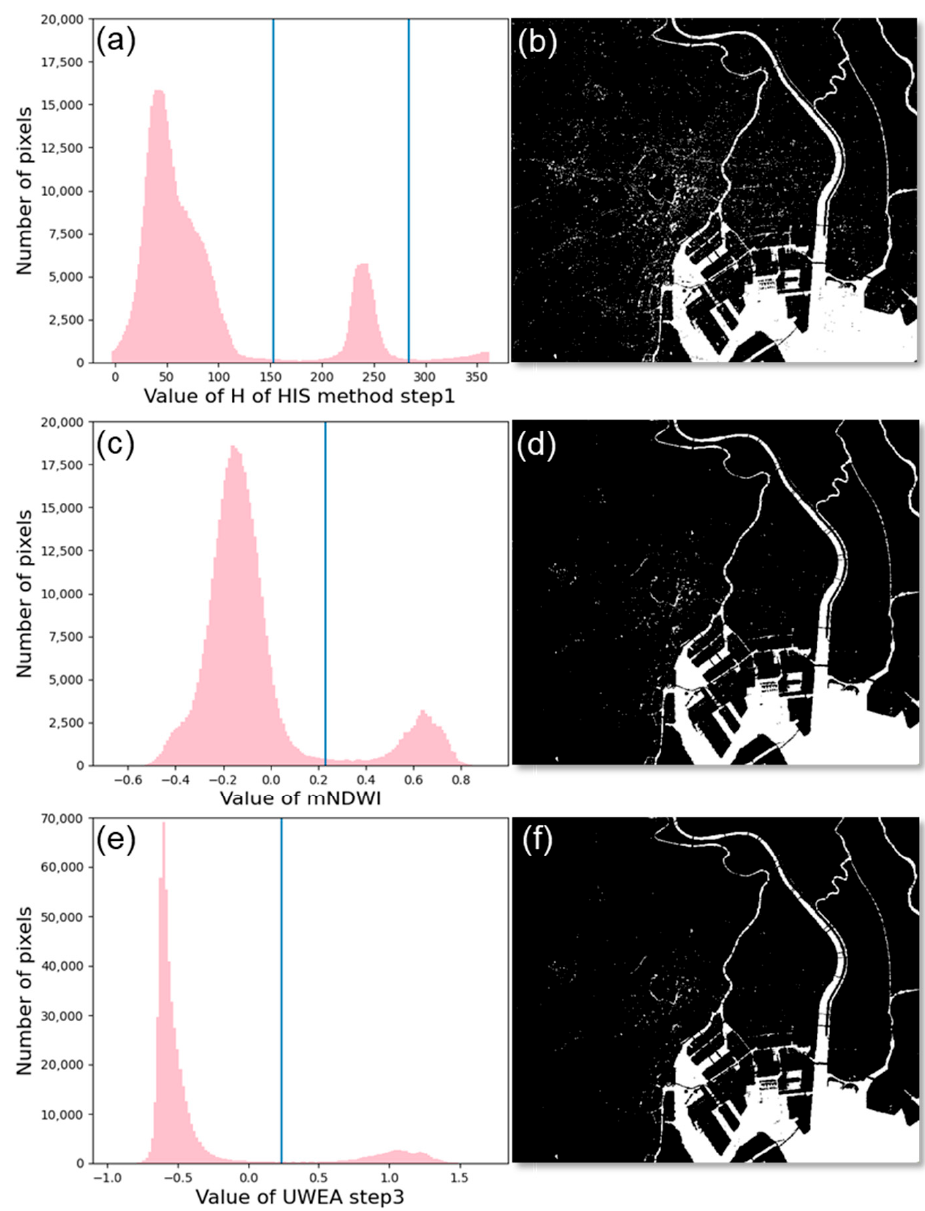
Figure 12. Subplots ( a , c , e ) are the frequency histograms of H of the first step of the HIS method, mNDWI, and the third step of the UWEA, respectively. The blue line is the threshold produced by the OTSU. Subplots ( b , d , f ) are the extracted results of the HIS method, mNDWI, and UWEA, respectively.